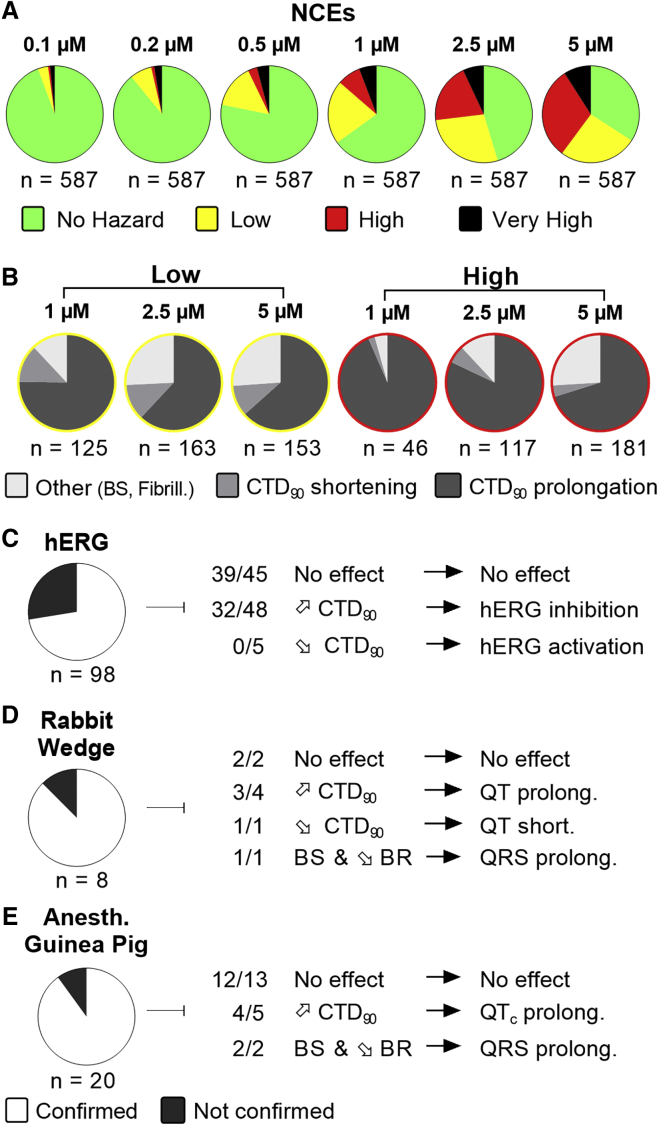
Hazard Evaluation Using the Scoring System on Janssen's NCEs in Discovery(A) Pie charts showing the concentration-dependent distribution of different hazard levels for NCEs (n = 587).(B) Analysis of CTD90 directional effect for NCEs scored with a low or high hazard at 1, 2.5, and 5 μM.(C–E) Translational confirmation of the CTCM-derived cardiac hazard scoring of NCEs that were also evaluated in (C) hERG, (D) isolated rabbit wedge, and (E) anesthetized guinea pig models. n indicates the number of NCEs tested in both the CTCM assay and the respective model.